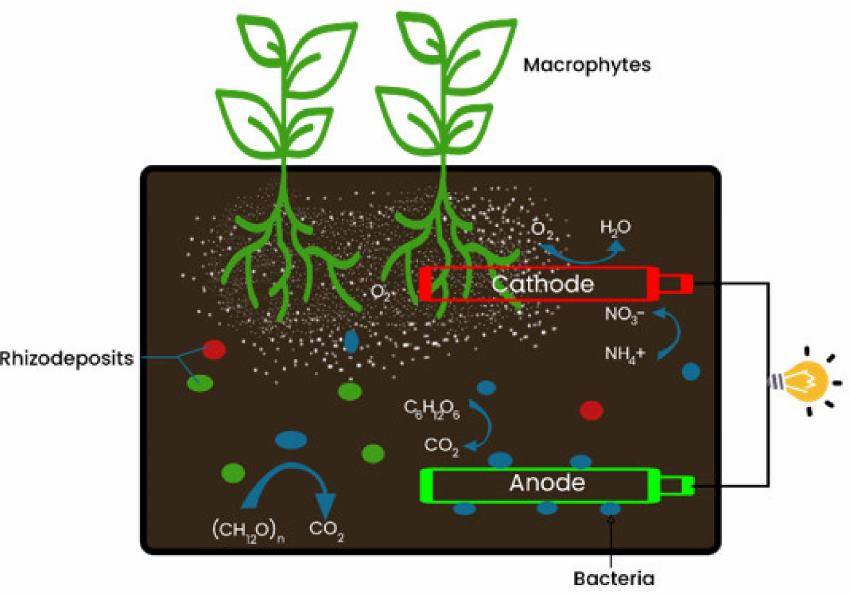
Figure 4. Macrophyte roots secrete O 2 and (CH 2 O)